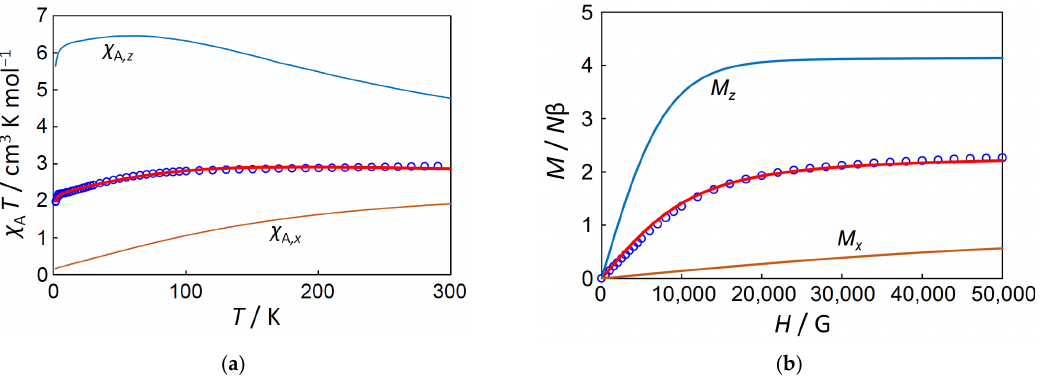
Figure 6. The χ A T vs. T plot and M vs. H plot for 2 . The observed data ( ○ ) and theoretical curves ( ‒ for average, ‒ for the z component, and ‒ for the x component) with the best-fitting parameter set ( λ , κ , ∆ , zJ [ θ ]) = ( − 142 cm − 1 , 0.90, − 1670 cm − 1 , − 1.4 cm − 1 [ − 0.23 K]). ( a ) The χ A T vs. T plot; ( b ) The M vs. H plot.